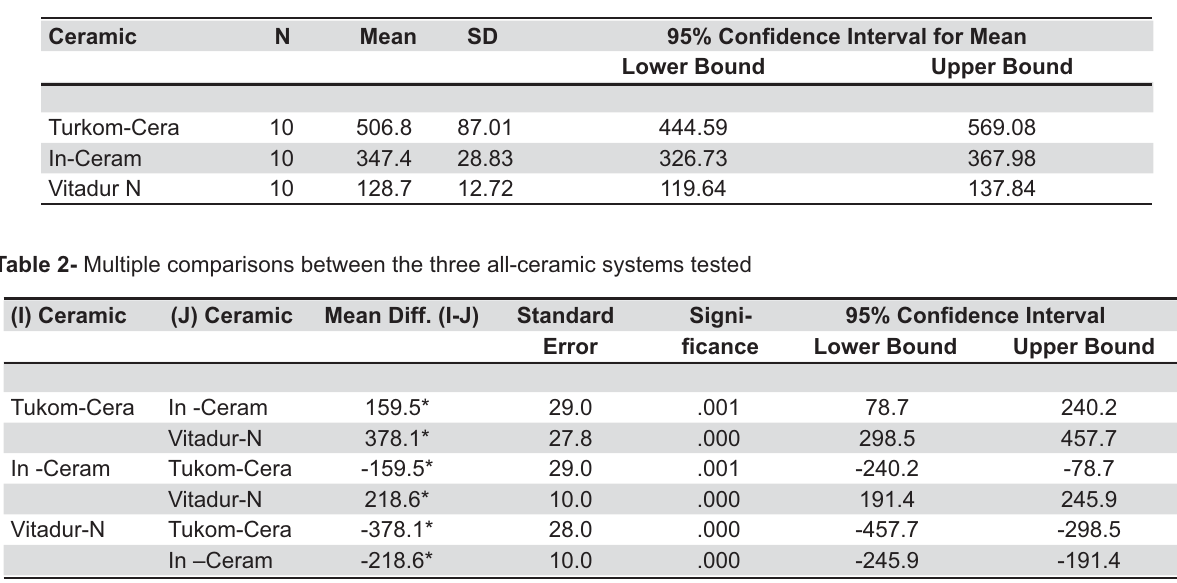
Table 1- (cid:2)(cid:3)(cid:4)(cid:5)(cid:6)(cid:2)(cid:5)(cid:6)(cid:7)(cid:2)(cid:8)(cid:9)(cid:5)(cid:6)(cid:7)(cid:5)(cid:10)(cid:7)(cid:2)(cid:7)(cid:4)(cid:11)(cid:12)(cid:5)(cid:9)(cid:12)(cid:13)(cid:6)(cid:2)(cid:14)(cid:15)(cid:16)(cid:17)(cid:2)(cid:13)(cid:18)(cid:2)(cid:19)(cid:12)(cid:5)(cid:20)(cid:12)(cid:5)(cid:21)(cid:2)(cid:22)(cid:4)(cid:20)(cid:23)(cid:10)(cid:5)(cid:21)(cid:2)(cid:8)(cid:9)(cid:10)(cid:4)(cid:6)(cid:24)(cid:9)(cid:25)(cid:2)(cid:13)(cid:18)(cid:2)(cid:9)(cid:25)(cid:4)(cid:2)(cid:9)(cid:25)(cid:10)(cid:4)(cid:4)(cid:2)(cid:24)(cid:10)(cid:13)(cid:23)(cid:26)(cid:8)